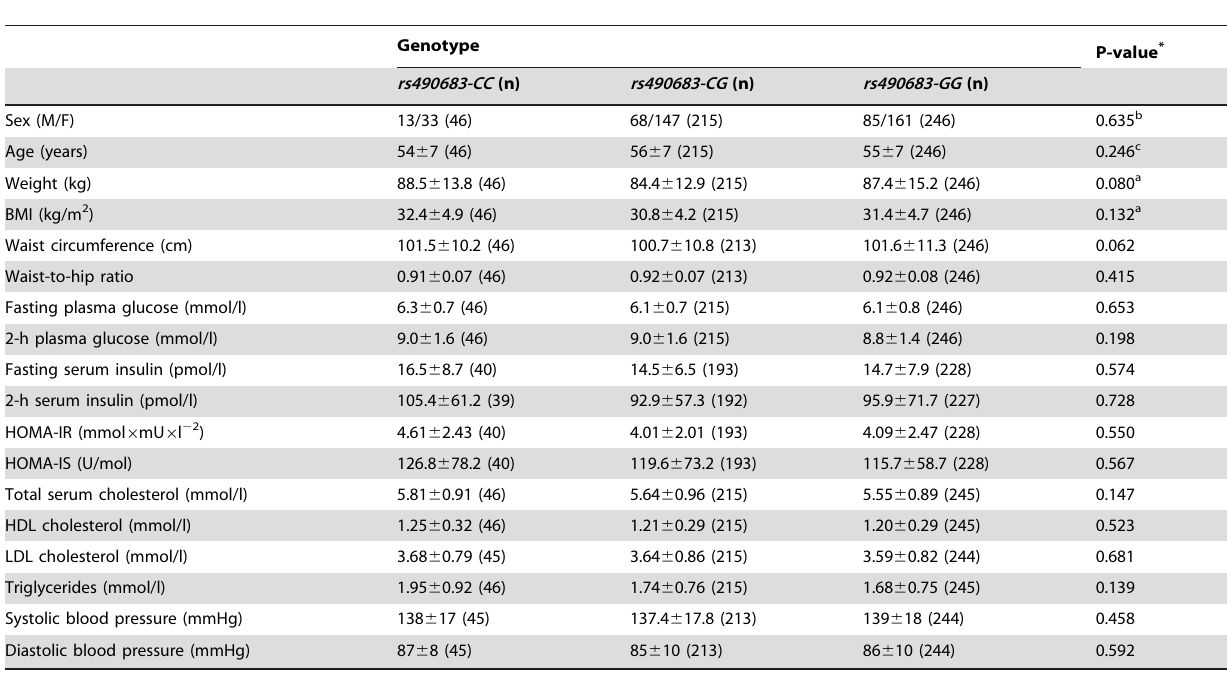
Table 1. Baseline characteristics of the DPS study subjects according to the rs490683 polymorphism of the GHSR gene.